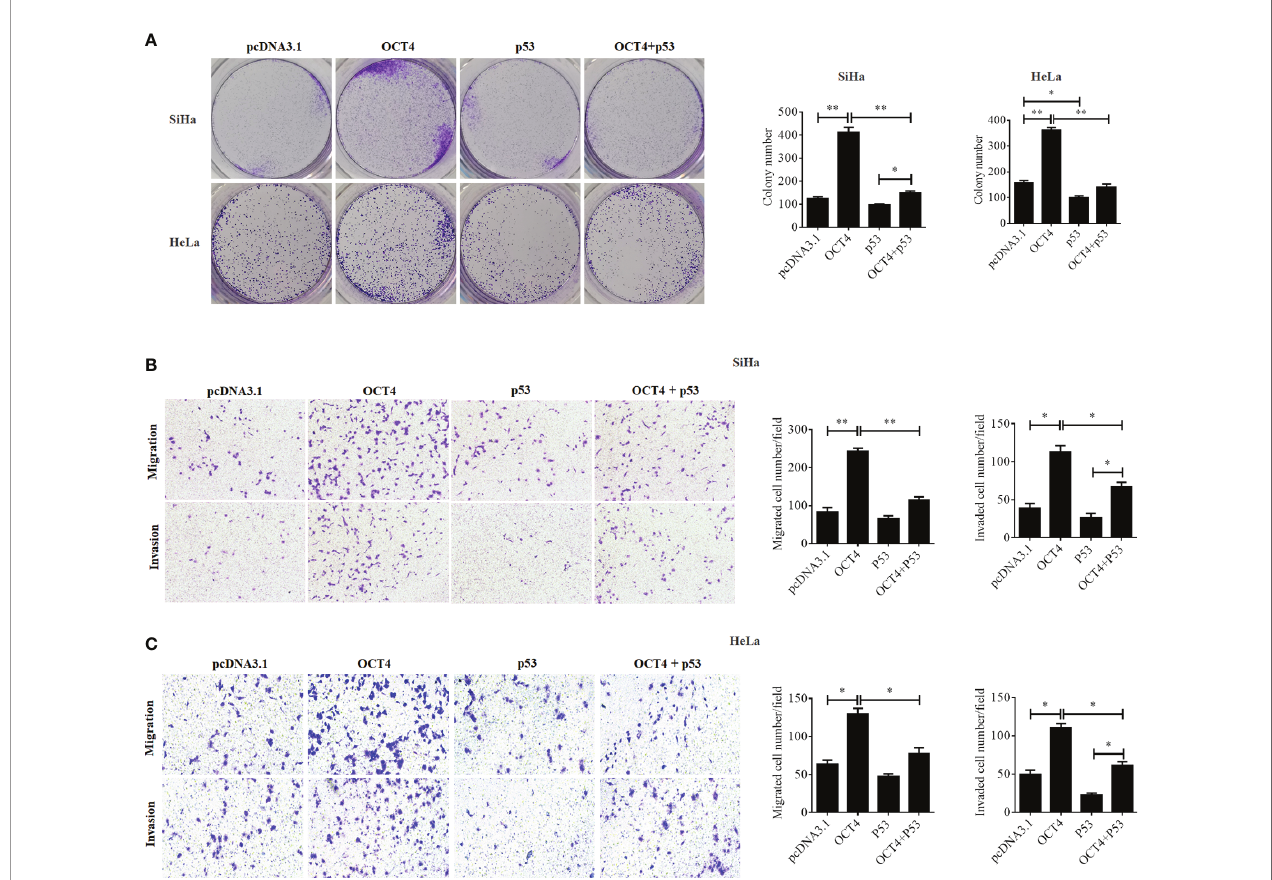
FIGURE 8 | OCT4 and p53 exerted opposite functions on cell migration, invasion, and colony formation activities in human cervical cancer cells. (A) The SiHa and HeLa cells were transfected with pcDNA3.1-OCT4 or pcDNA3.1-p53 alone or in combination. After transfection, representative photographs of colony formation in SiHa and HeLa cells were shown. (B) Transwell assay analysis of migration and invasion abilities in SiHa cells treated as in (A) . (C) Transwell assay analysis of migration and invasion abilities in HeLa cells treated as in (A) . * p < 0.05, ** p < 0.01 vs.